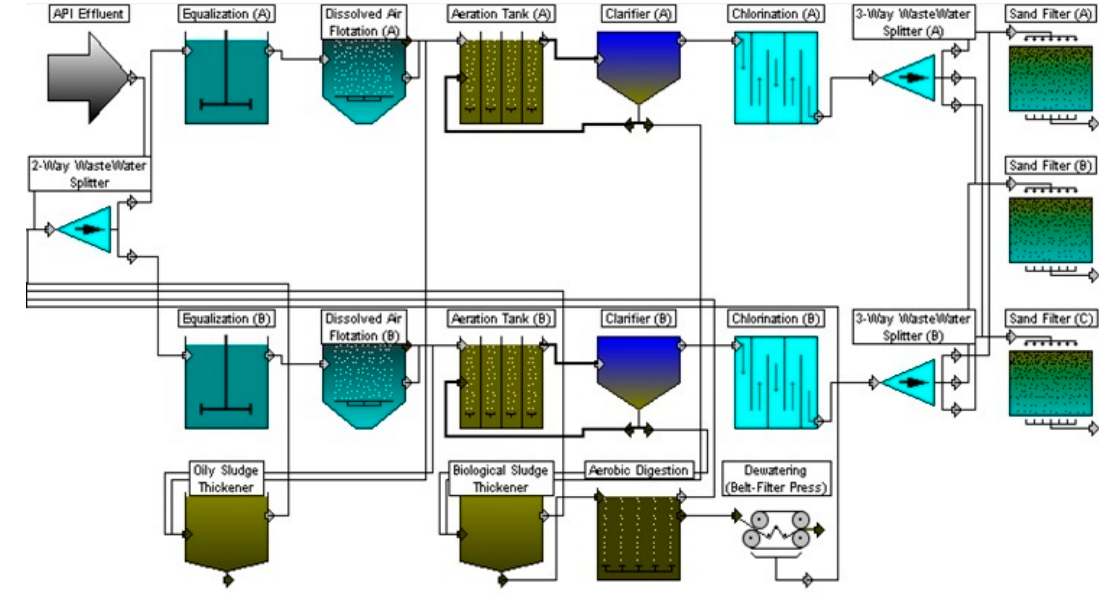
Figure 1. Process flow diagram of the petroleum refinery wastewater treatment plant (PRWWTP) containing conventional activated sludge (CAS) + CAS processes.